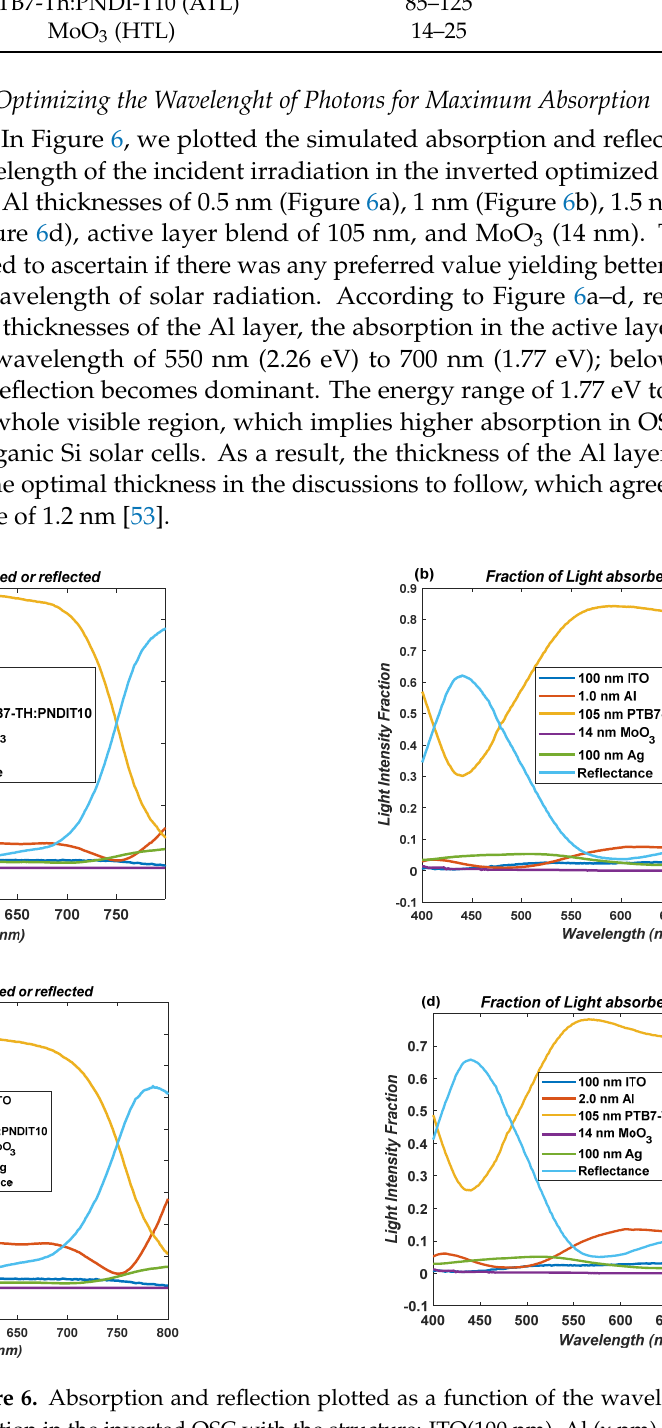
(100 nm)/SiO 2 (20 nm)/PEDOT:PSS (40 nm)/PTB7-Th:PNDI-T10 (105 nm)/LiF (1 nm)/Al (100 nm); (inverted): ITO (100 nm)/SiO 2 (20 nm)/Al (1 nm)/PTB7-Th:PNDI-T10 (105 nm)/MoO 3 (20 nm)/Ag (100 nm). The contour plots of electric field distribution within the active layer of conventional and inverted OSCs are shown in Figure 7a,b, respectively. In both figures, the spread of brighter spot represents the constructive interference position (CIP) between the forward and reflected electric field components, and both figures have only a single CIP with spread covering nearly the whole active layer. This was consistent with our earlier work [33] on different OSCs, where a single CIP was found within the active layer of 150 nm. The CIPs represent positions of maximum photon activity, which can lead to maxi- mum exciton generation at these points, where CIP overlaps with the region of maximum photon absorption in the active layer blend. It may be noted here that most generated excitons get dissociated within the active layer; therefore, the brighter spots represent the positions of generation of dissociated charge carriers within the active layer. The contour